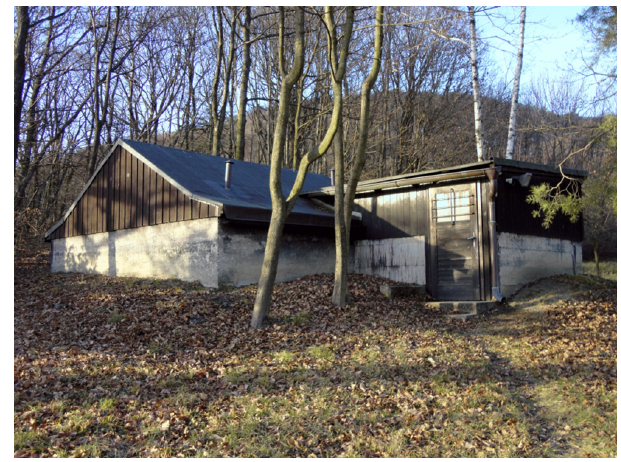
Figure 6. Main part of the former geomagnetic observatory at the Cobenzl in Vienna, which was in operation from 1954–2016 (ZAMG